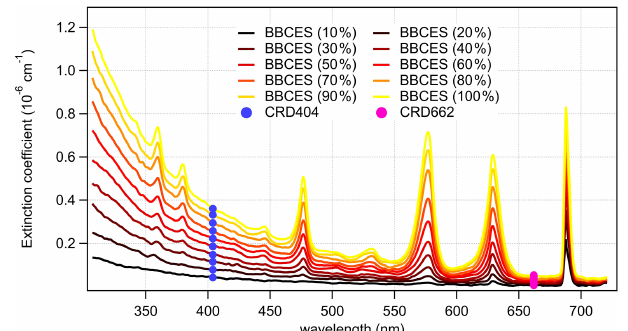
Figure 2. Wavelength-dependent extinction coefficients of O 2 + He mixtures as a function of O 2 concentration. The colored lines rep- resent the extinction coefficients measured by BBCES system, and markers represent results from CRDS setup.